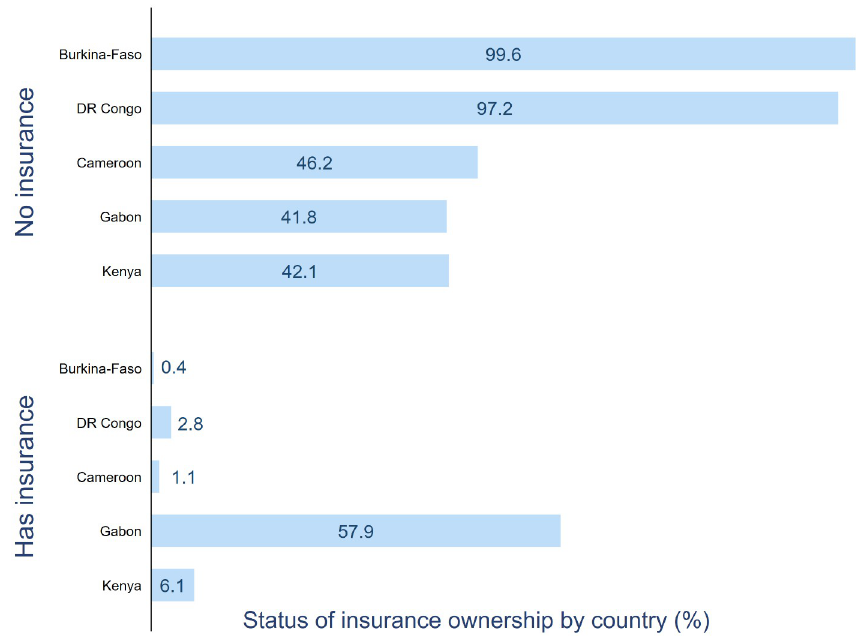
Fig 1. Percentage of participants with a health insurance by country.